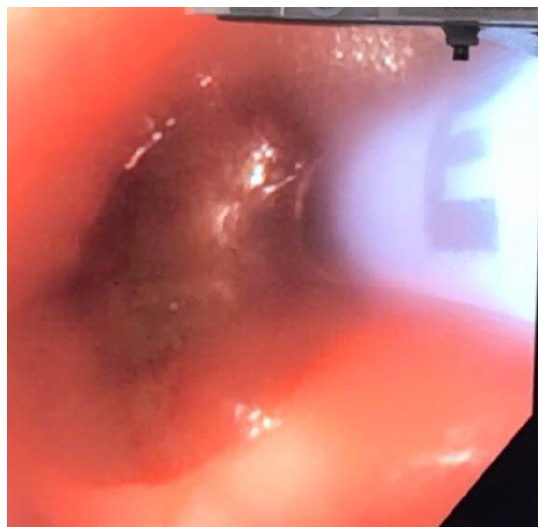
Figure2. Removal of the leech by Cryoprobe.